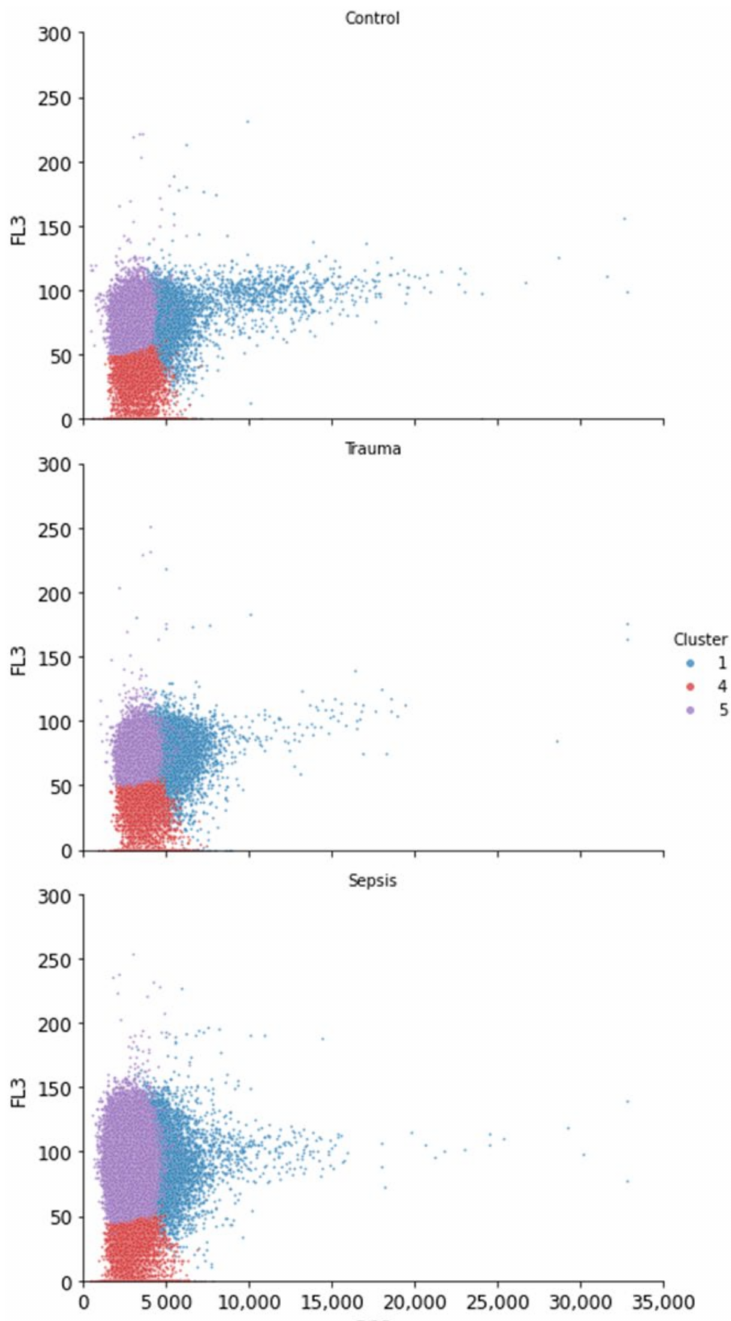
Figure 4. What defines the three neutrophil clusters? Cluster 1 (blue) is described by relatively high DSS/PSS and FL3 values, cluster 4 (red) is described by low FL3 and DSS/PSS values, and cluster 5 (violet) is described by relatively high FL3 values and low DSS/PSS